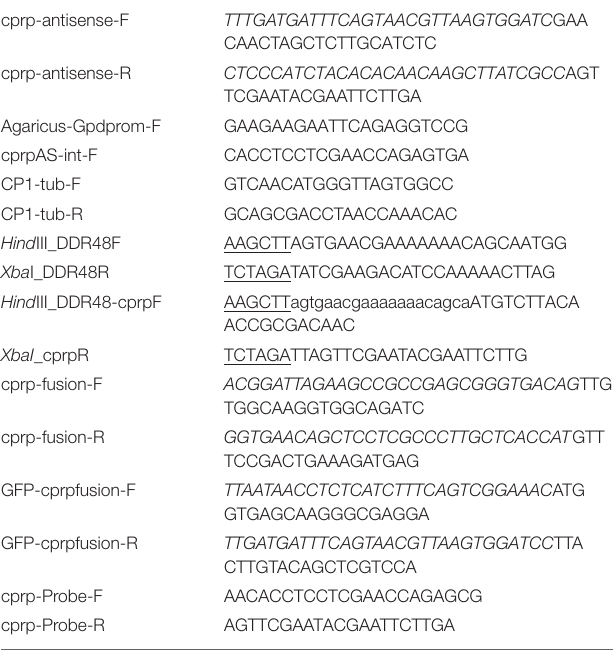
TABLE 2 | Primers used in this